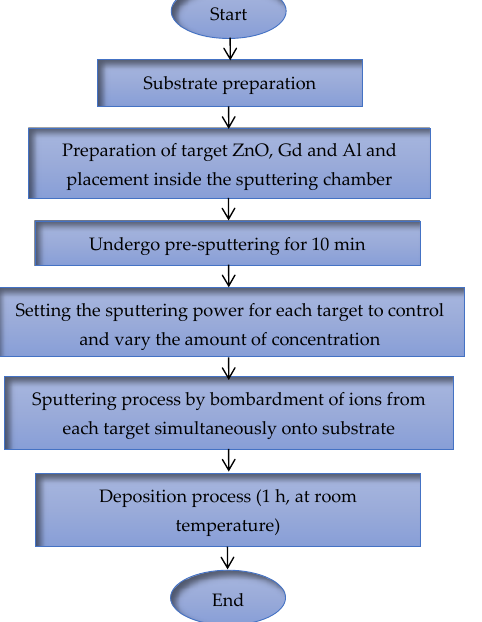
Figure 1. Flow chart of deposition process of undoped ZnO, Gd-doped ZnO at various Gd concentrations, and (Gd, Al) co-doped ZnO. The crystal structure and phase indications of the films were measured by X-ray diffraction (XRD), using PANalytical X-Pert Powder. All the samples were scanned by setting the Cu Kα radiation wavelength as λ = 0.1540 nm with a 2θ degree angle within the range of 20° – 80°. The atomic percentage (at%) of the Gd and Al doping composition were assessed via EDX analysis by attaching the probe to the field electric scanning elec- tron microscope (FESEM) using a JEOL JSM-7600F. The transmittance spectra and energy band gap of the films were determined from UV – Vis spectroscopy. The magnetic domain structures of samples were examined in detail at the nanometer scale by Magnetic Force Microscopy (MFM), with all samples scanned in dimensions of 1 μm × 1 μm. The MFM utilizes a magnetic tip to evaluate the magnetic force gradient distribution from a sam- ple’s surface by oscillating the cantilever normal to the surface at its resonant frequency. The magnetization of the MFM tip with high lateral resolution and high coercivity is placed perpendicular to the sample surface and points downward. All the MFM images were produced at the same lift scan height of 50 nm, utilizing the tapping mode meas- ured at room temperature. Magnetization measurements were measured using a vibrat- ing sample magnetometer (VSM) (LakeShore 7404, Carson, CA, USA) with a maximum